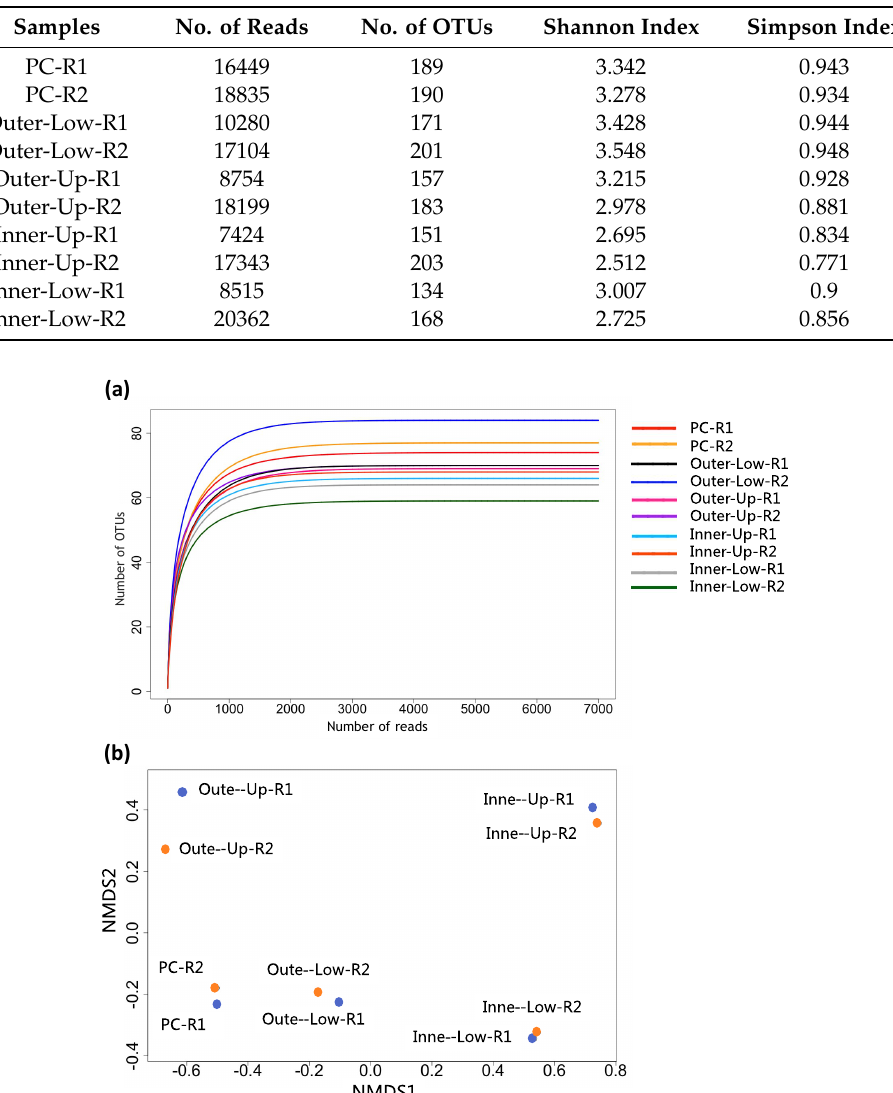
Table 2. Numbers of reads and operational taxonomic units (OTUs), along with values of alpha diversity index, Shannon’s diversity index, and Simpson’s diversity index for the microbial communities of di ff erent samples from the anodes of the bioelectrochemical system-trickling filter (BES-TF) reactors R1 and R2. PC: planktonic cells, Outer-Low: Outer biofilm of the lower part of the anode (submerged in wastewater), Outer-Up: Outer biofilm of the upper part of the anode (not submerged in the wastewater), Inner-Low: Inner biofilm of the lower part of the anode (submerged in wastewater), Inner-Up: Inner biofilm of the upper part of the anode (not submerged in the wastewater).